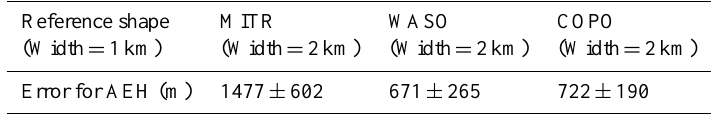
Table 5. The error for AEH due to the change in aerosol vertical distribution. Reference shape